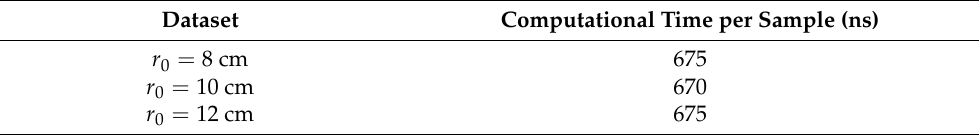
Table 8. Means of the computational time needed by the FCN model per sample for each test dataset.